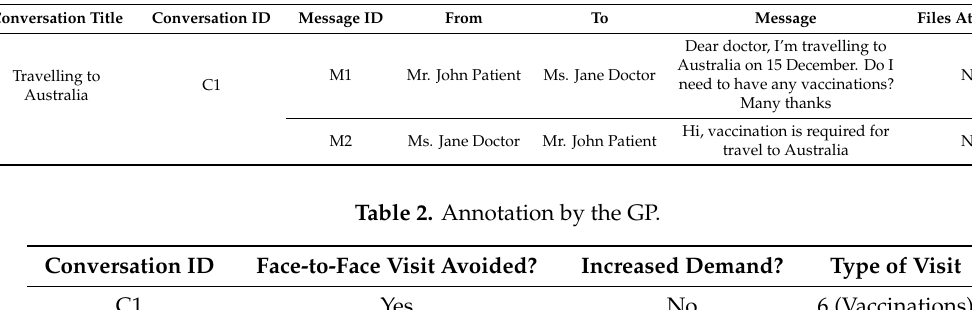
Table 1. Data recorded by the teleconsulting system.